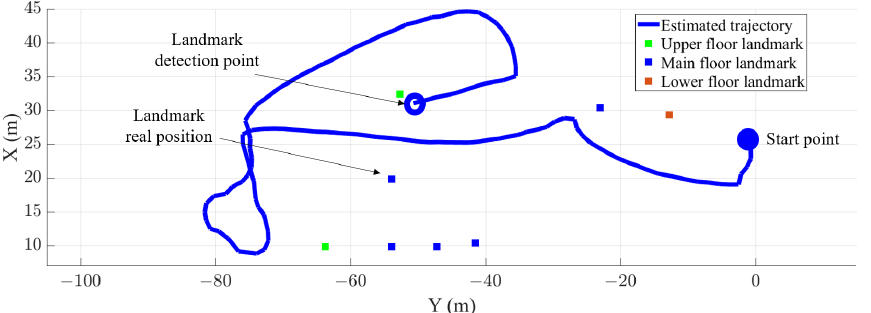
Figure 17. Estimation of a passenger trajectory in a traffic hub while walking through the main floor of the test station (solid blue) and the position of the landmarks (squares). The green squares represent the landmarks in the upper floor, the blue squares represent the landmarks in the main floor and the orange squares represent the landmarks in the lower floor of the test